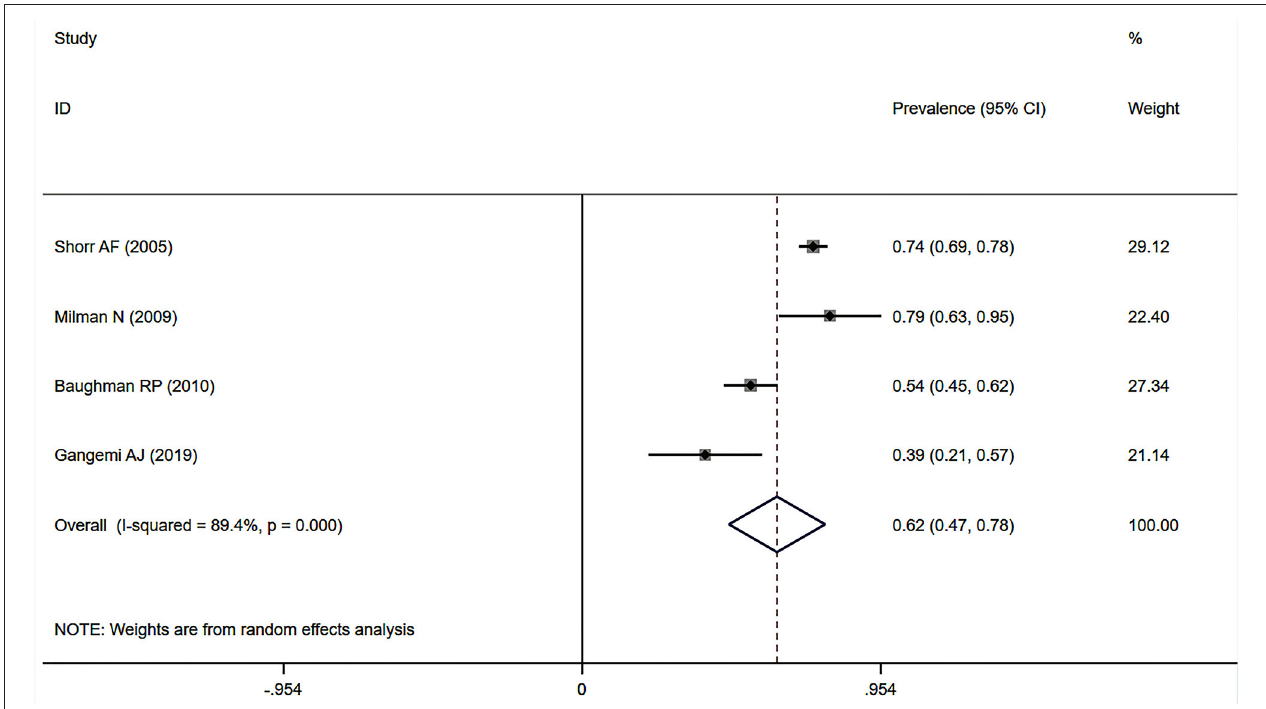
FIGURE 4 | Forest plot of the pooled prevalence of SAPH by RHC in advanced sarcoidosis population. SAPH, sarcoidosis-associated pulmonary hypertension; RHC, right heart catheterization.